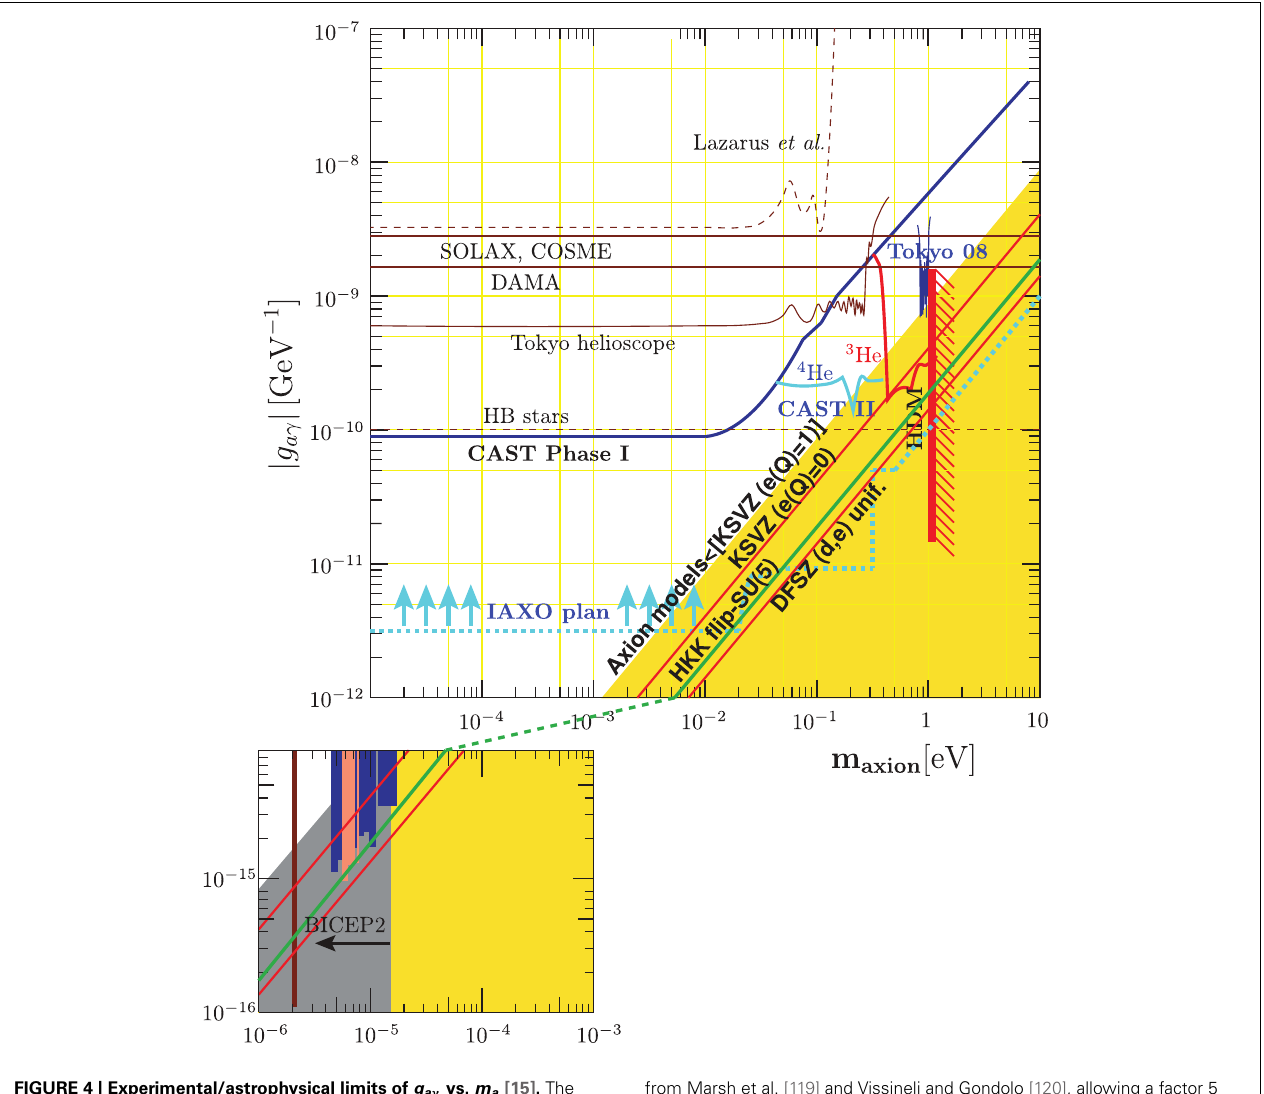
from Marsh et al. [119] and Vissineli and Gondolo [120], allowing a factor 5 generosity due to the domain wall annihilation problem [165]. The astrophysics lines in the bigger box represent that the regions above those lines are